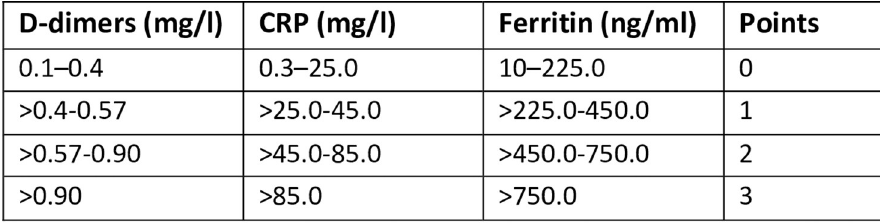
Fig 1. A simplified SCOPE score. CRP: C-Reactive protein. Each of the three biomarkers is allocated 0 to 3 points according to the concentration. The final score is the addition of the points provided by each biomarker.